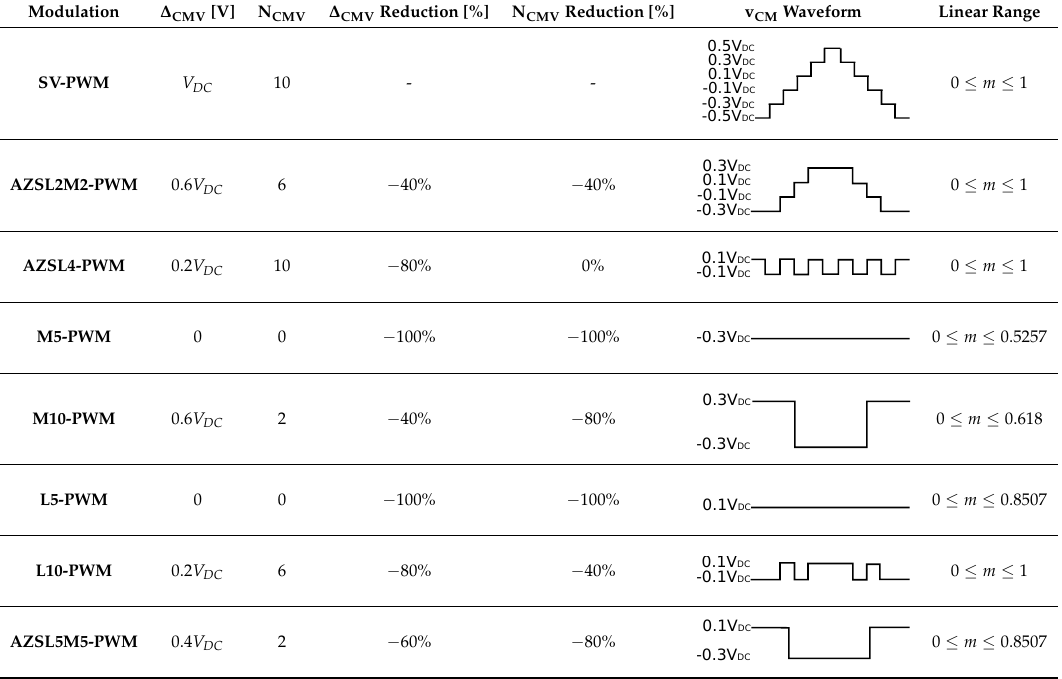
Table 2. Summary of the most relevant features of SV-PWM and RCMV-PWM